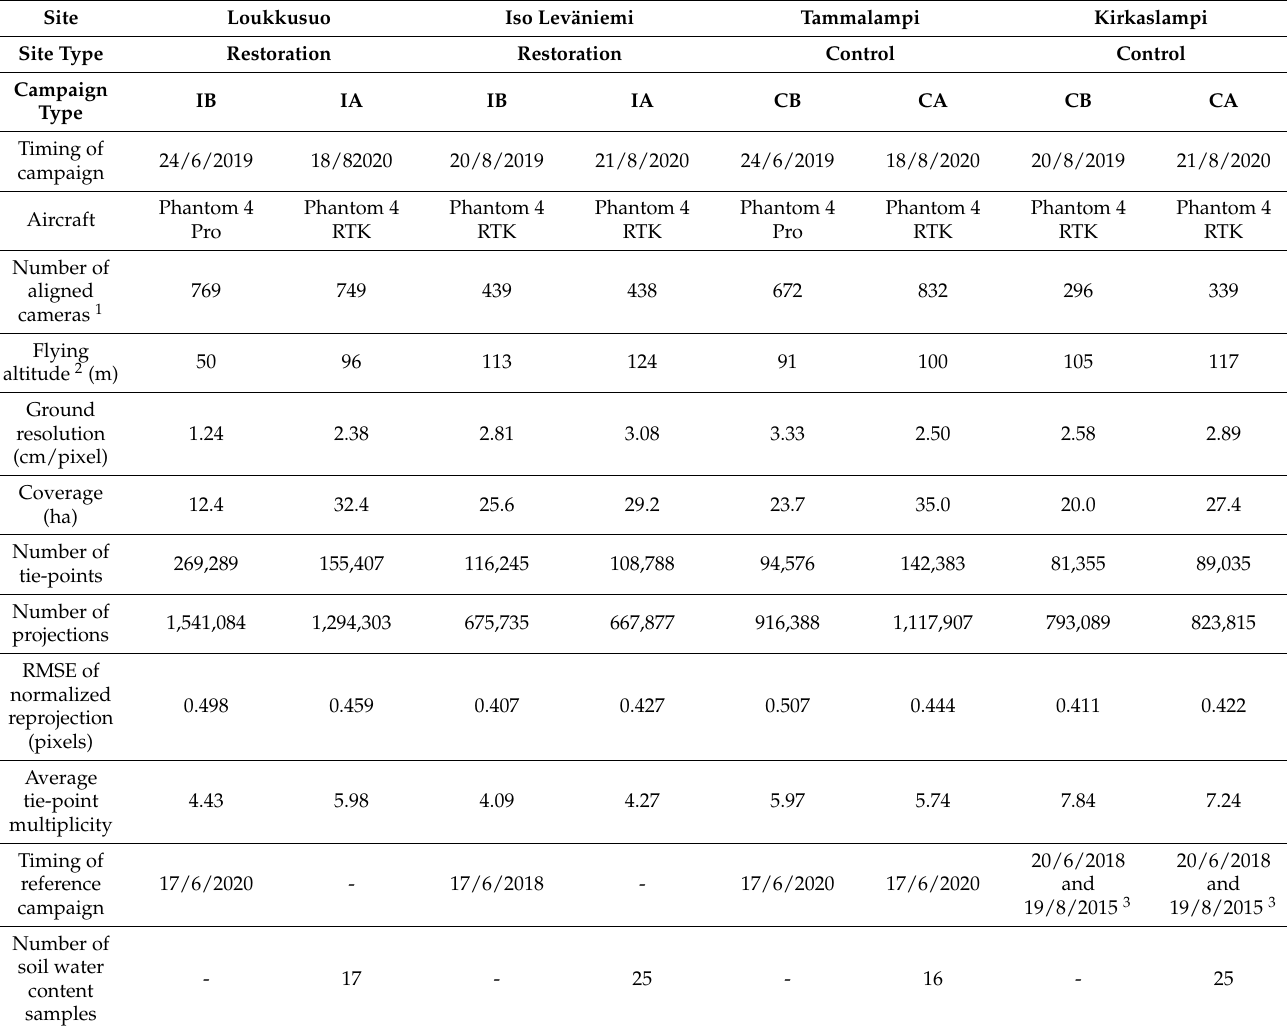
Table 2. Campaign timings and unmanned aircraft system (UAS) data and processing information according to Metashape. RMSE = root mean square